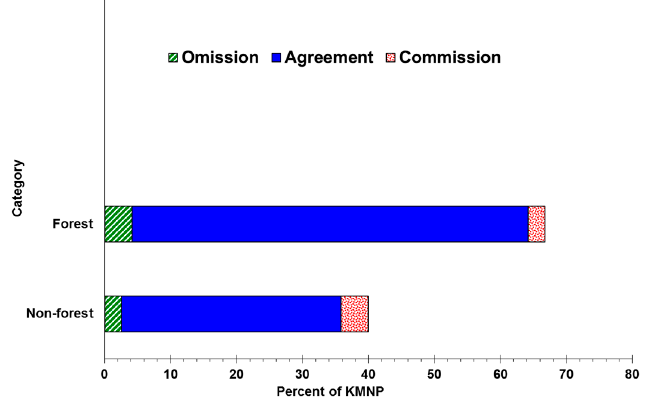
Figure 4. Category level analysis of agreement, omission disagreement and commission disagreement for burn classification. Land cover categories are on the vertical axis while the reference pixels are on the horizontal axis.